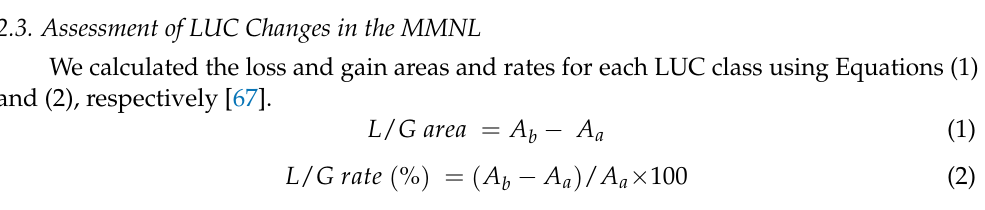
Table 1. Wetland classification scheme used in this study. LUC Class Land Surface Features Urban, residential, industrial, transportation (roads, train lines), Settlement communications and utilities infrastructure, airports, home gardens, concrete structures, power plants, and asphalt areas. Seasonally flooded areas with abandoned paddy fields, intermittently Marshland flooded areas with agriculture, marsh plant communities, trees, scrub and grassland, peat soil, bog soil and back swamp, and other cultivated areas. Seasonally flooded areas with mangroves, intermittently flooded areas Mangrove with mangroves and mangrove pneumatophore areas. Water Lagoon, streams, canals, and